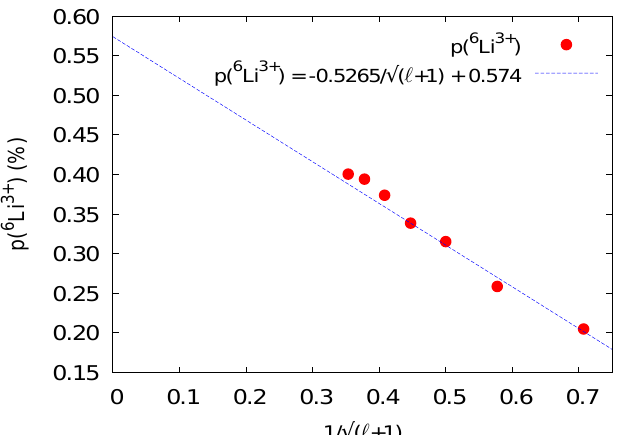
Figure 3. An example of convergence, following the beta decay of 6 He ( 1s2s 3 S 1 ) , with respect to the number of partial waves (cid:96) (red dots) for the 6 Li 3 + probability for the case Ω 1 = Ω 2 =